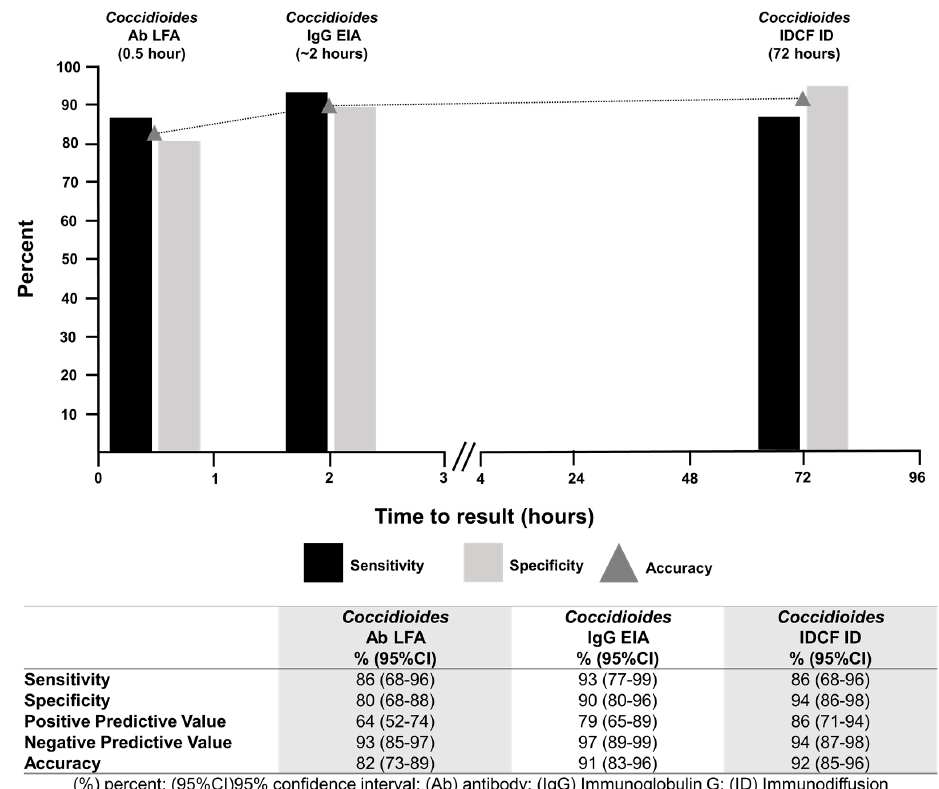
Figure 2. Comparison of the sensitivity, specificity, analytical performance, and time to results with the IMMY ® s ō na Coccidioides total antibodies (Ab) lateral flow assay (LFA), modified IMMY ® Coccidioides Ab Enzyme Immunoassay (EIA), and the IMMY ® IDCF immunodiffusion for the detection of anti- Coccidioides IgG Ab in dog serum.